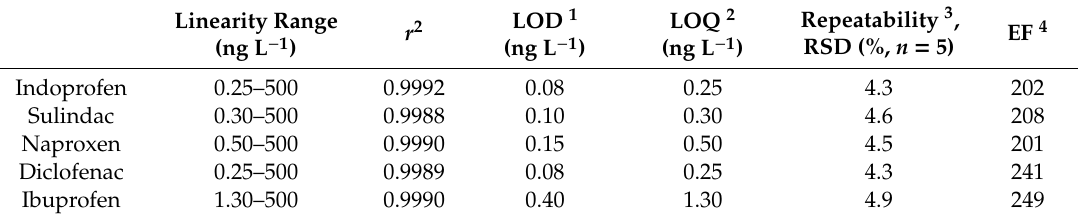
Table 2. Linear range, correlation coe ffi cient ( r 2 ), detection limits (LODs), quantification limits (LOQs), repeatability, and enrichment factors (EFs) of nonsteroidal anti-inflammatory drugs (NSAIDs) in spiked water samples in combination with UPLC–MS / MS.